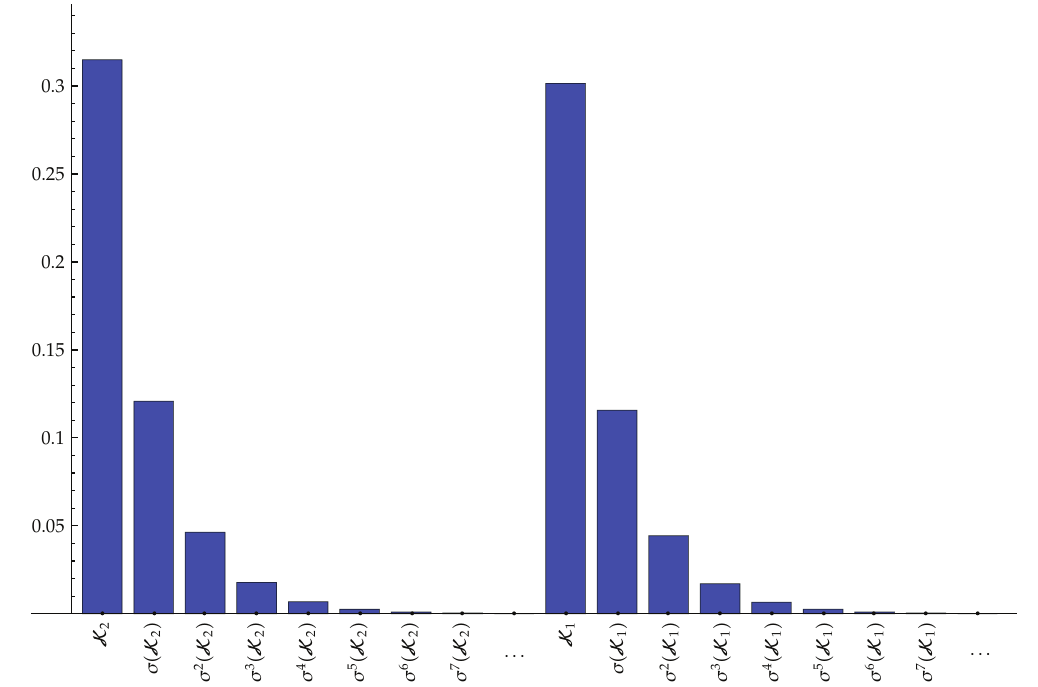
Figure 2: Histogram of the relative frequencies of the distinct critical values of φ 12 (cid:5) T 12 φ 0 , whose itineraries are given by σ q (cid:2) K 1 (cid:3) , σ q (cid:2) K 2 (cid:3) , q (cid:5) 0 , 1 , 2 , 3 ,... . Note that the order of these itineraries is K 2 , σ (cid:2)